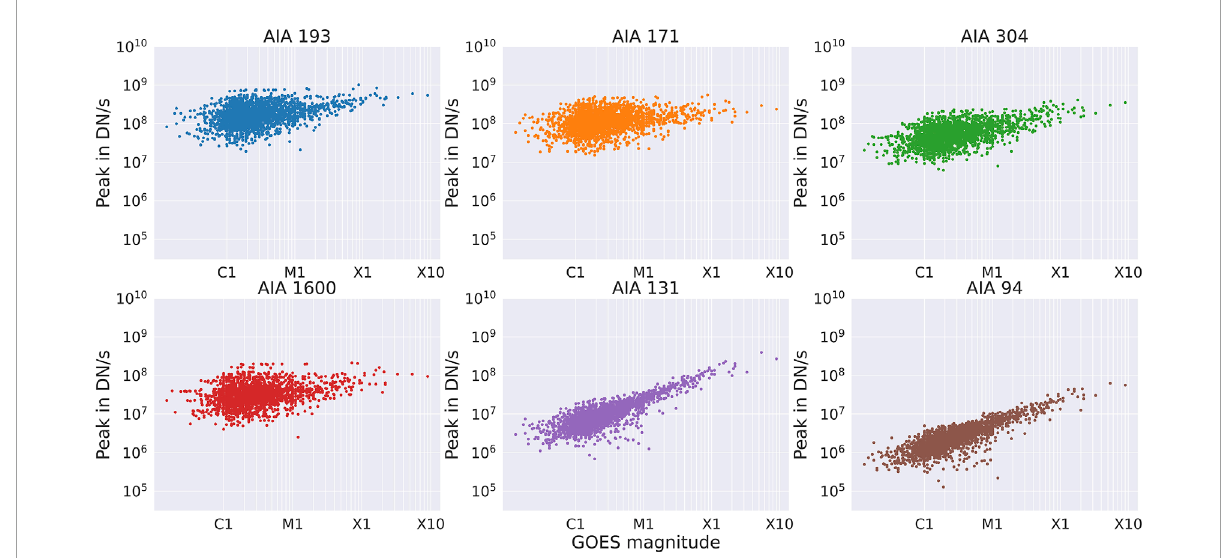
FIGURE 3 Peak intensity in AIA wavelengths as a function of GOES flare magnitude. Units of AIA intensity are “Data Numbers” (DN) per second, i.e., raw detector output not calibrated to irradiance units. In all cases, decreasing GOES magnitude is associated with higher spread in AIA intensities. The 131 and 94 Å channels show the tightest correlation with GOES X-ray